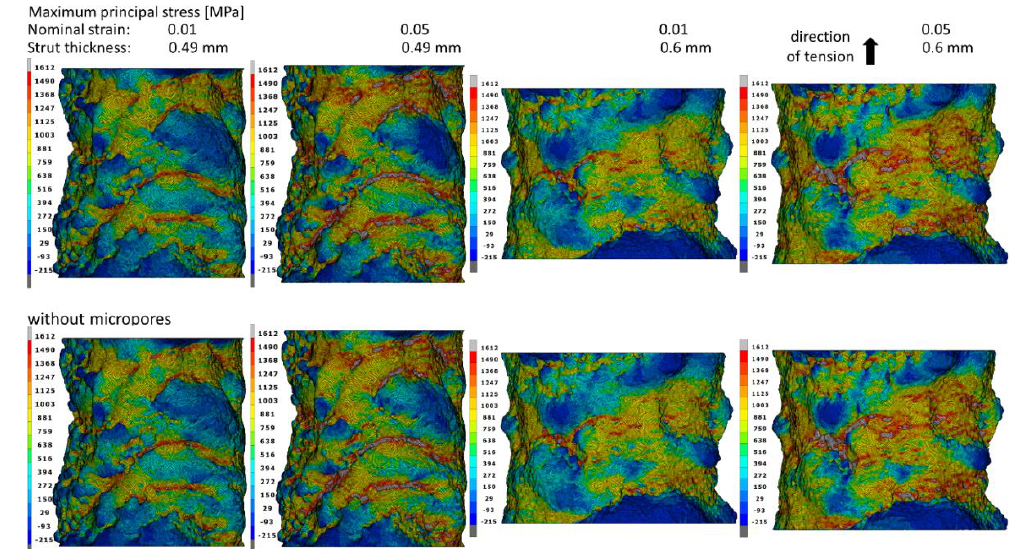
Figure 10. Maximum principal stress fields on the struts ’ surfaces with and without micropores at the moment of obtaining the nominal strains of 0.01 and 0.05.